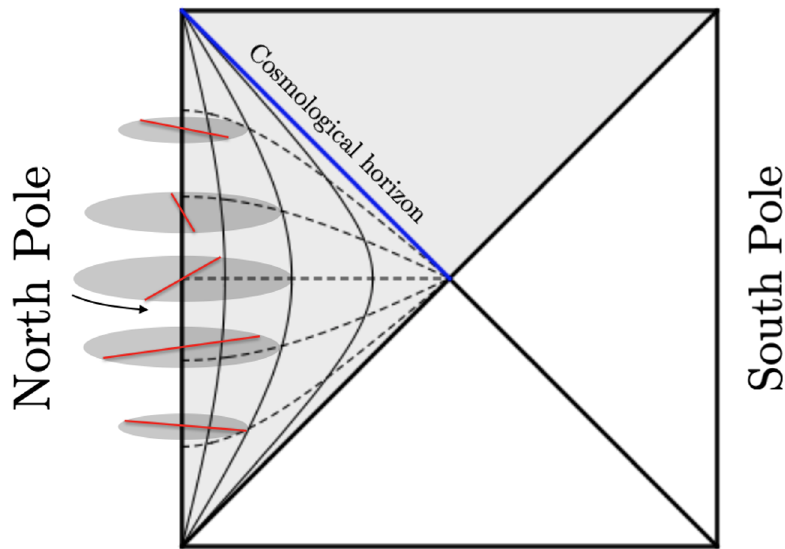
Figure 1 . Penrose diagram of dS 3 : each point represents an S 1 subspace and the edges correspond to the north and south poles of S 2 . For example, the planar coordinates cover a half of the whole space (the shaded region) and the cosmological horizon for an observer sitting at the north pole is the blue line. The static coordinates cover a half of the planar coordinates Y 0 , that is inside 3 ± Y 0 ≥ the cosmological horizon. The dotted and rigid curves are sections of constant t and r(= sin ρ ) , respectively. We study strings rotating around the center r = 0 ( ρ = 0 ) of the static